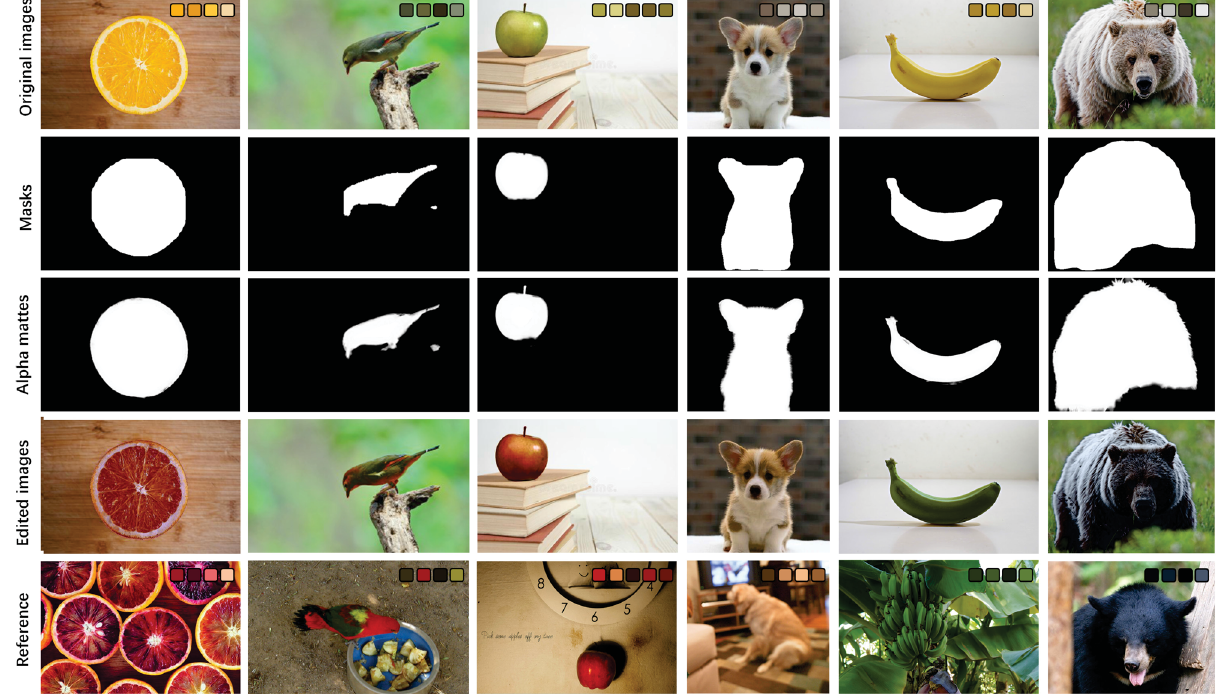
Fig. 8 Various results of our instance-based recoloring approach. Top row: original images with their original palettes at the top right. Rows 2, 3: detected masks and corresponding alpha mattes, respectively. Row 4: color transfer results. Row 5: target palettes used and corresponding reference